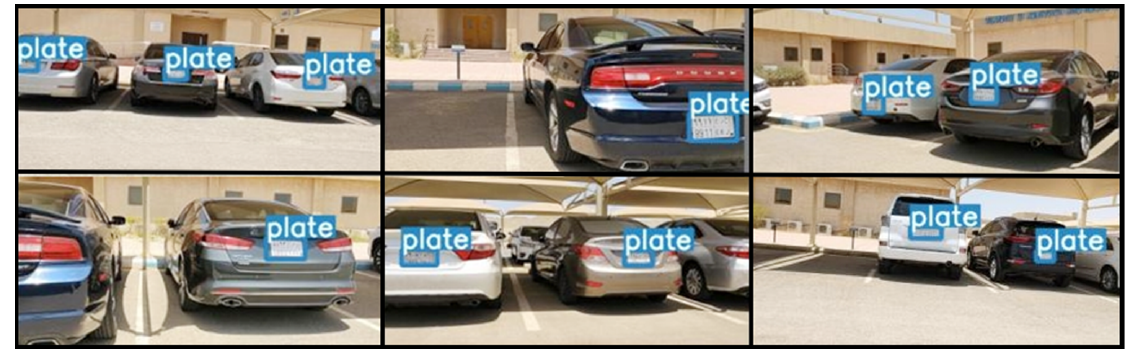
Figure 6. YOLOv5 detection of license plates.